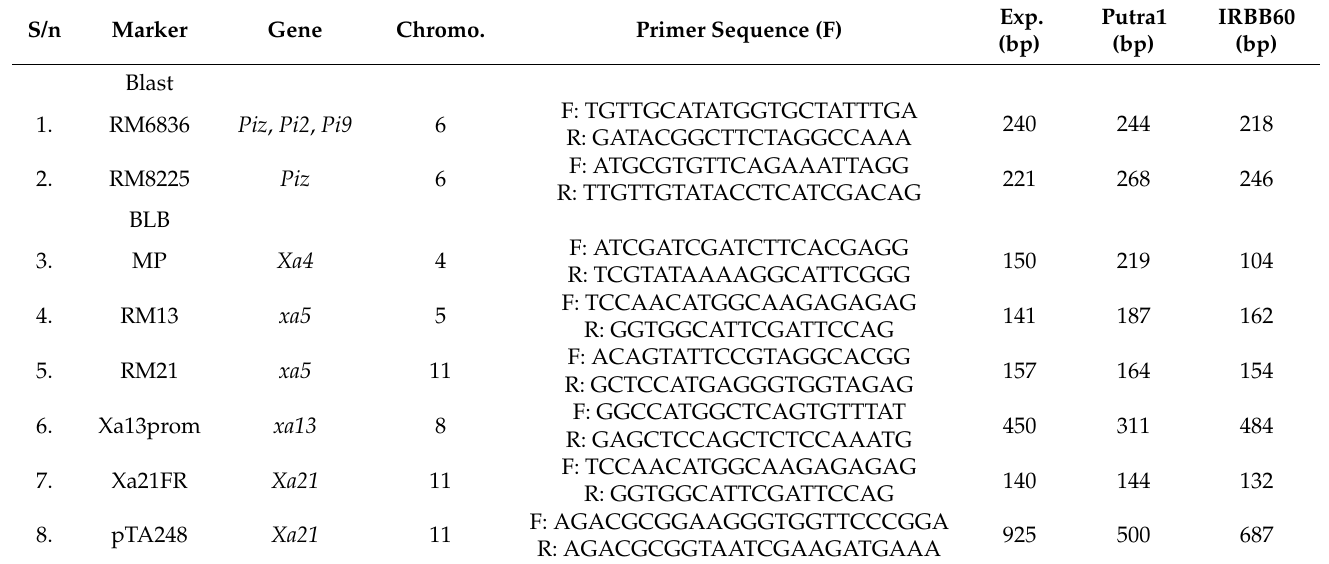
Table 1. SSR marker information used for the genotypic selection of the newly improved rice